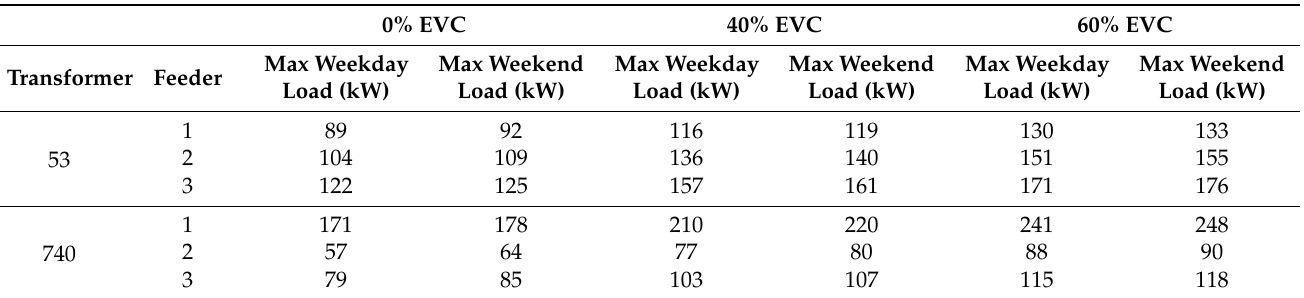
The peak loads of LV network in summer (weekdays and weekend) with 0%, 40%, and 60% EVC penetration levels for Feeders 1, 2, and 3 of each transformer are shown in Table 5 from the CYME software. Simulation results of load flow and long-term-dynamic analyses were recorded during the peak day of summer season in order to consider the worst case scenarios. Peak load of feeders A4 and Y505, which supplies transformers 53 and 740 was recorded. The current in summer reached 178 A on 13 August at 23:00. The load percentage with 0% EVC is below the loading limit of each feeder, which makes the feeder able to handle further increase in loading. The load percentage has increased to 70% for Transformer 740, Feeder 1, and 60% for Transformer 53, Feeder 3. Charging EVs with 40% and 60% penetration during summer led to a further drop in the voltage levels of the LV feeders. Table 5. Peak loads of the LV network in summer with 0%, 40% and 60% EVC.